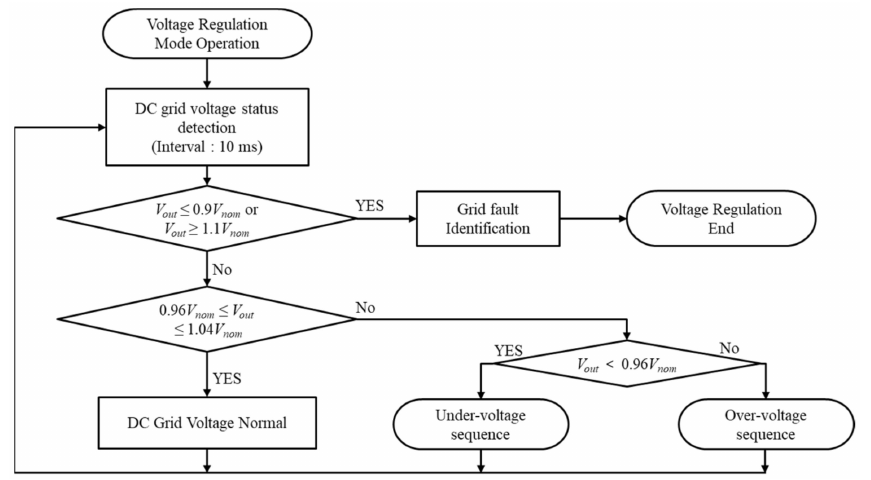
Figure 9. Flowchart of voltage regulation